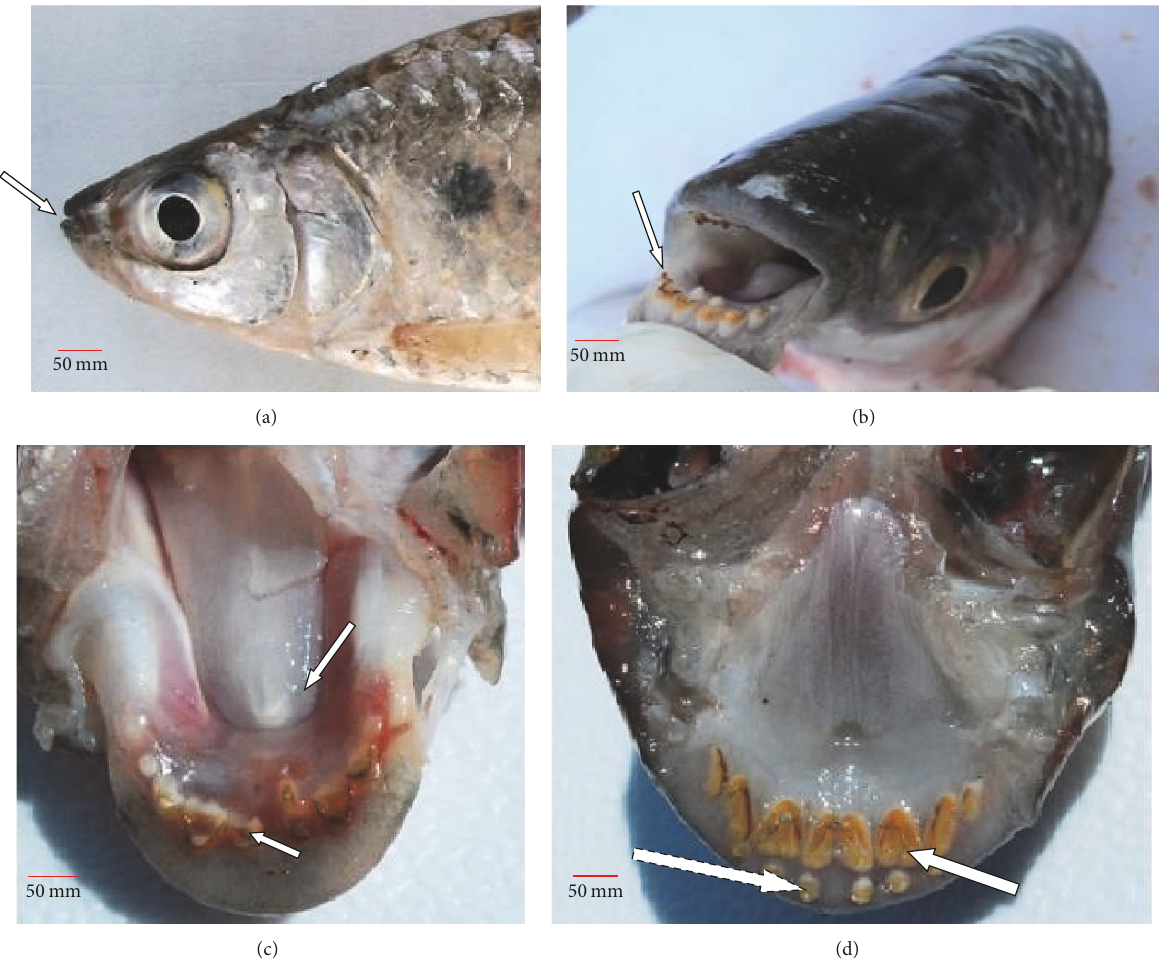
Figure 2: Gross morphology: (a) terminal mouth ( ), (b) dentition ( ), (c) tongue ( ) molar on the dentary ( ) in the lower jaw, and (d) molar ( ) and conical teeth ( ) on the premaxilla in the upper